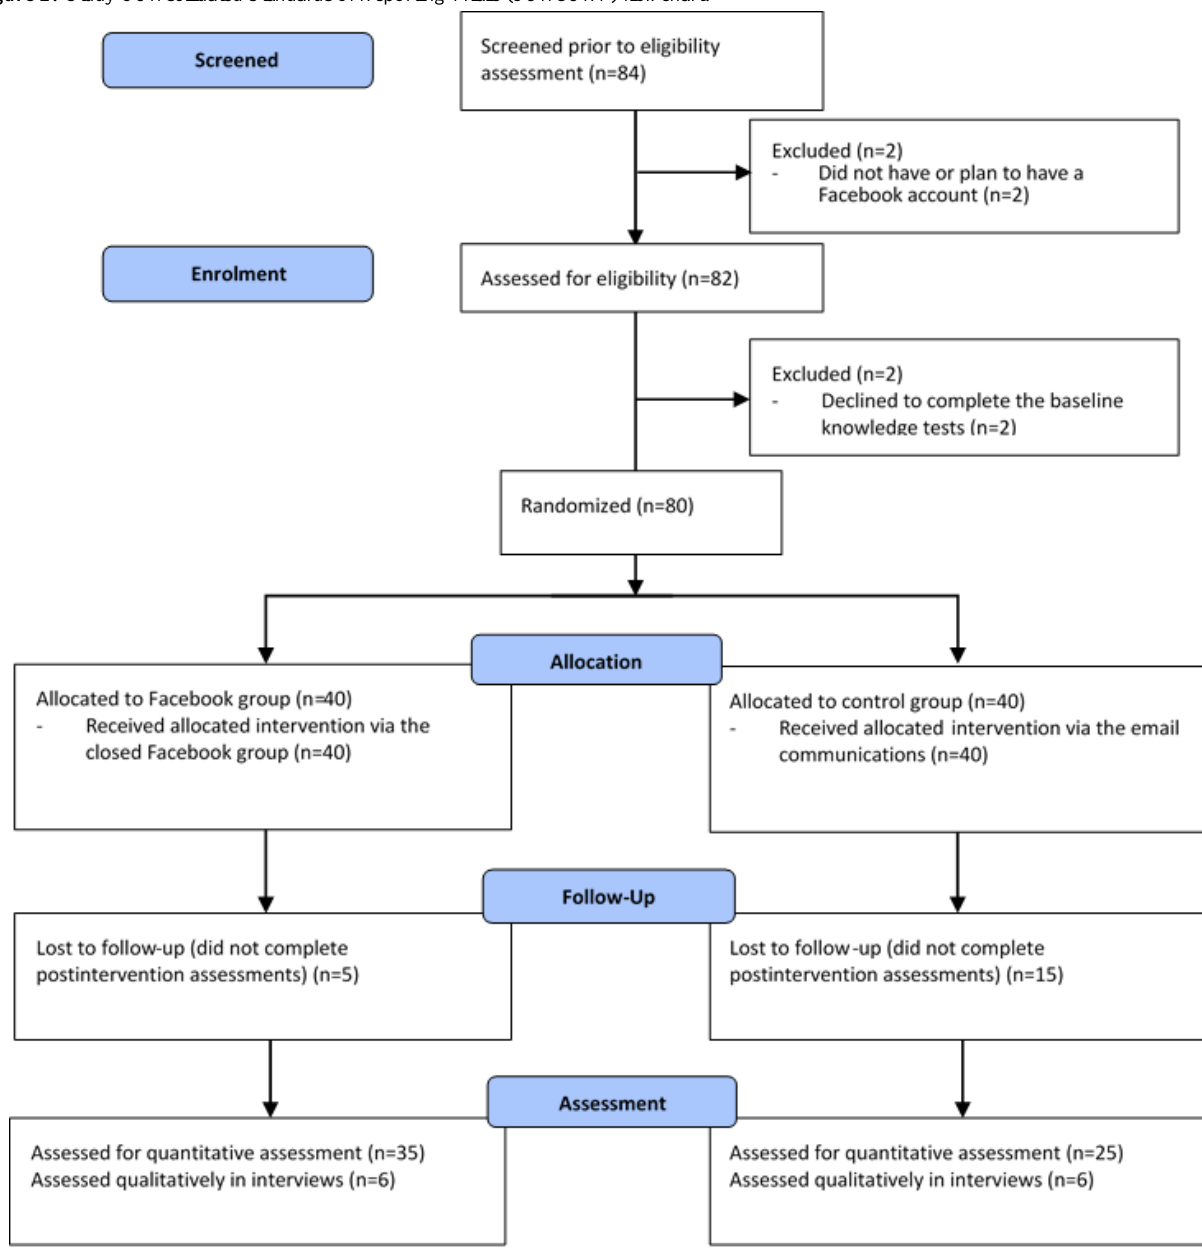
Figure 2. Study CONsolidated Standards of Reporting Trials (CONSORT)